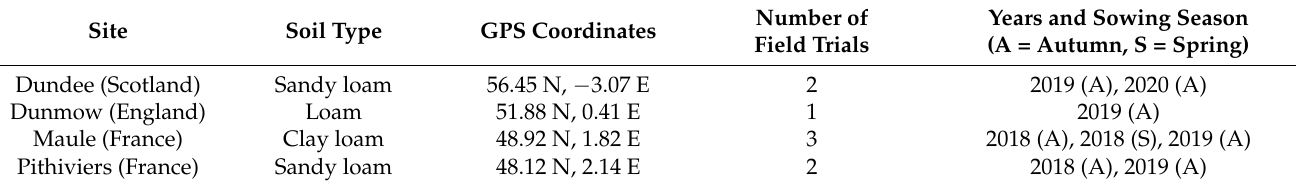
Table 1. Field trials of barley collection for resistance to rhynchosporium.